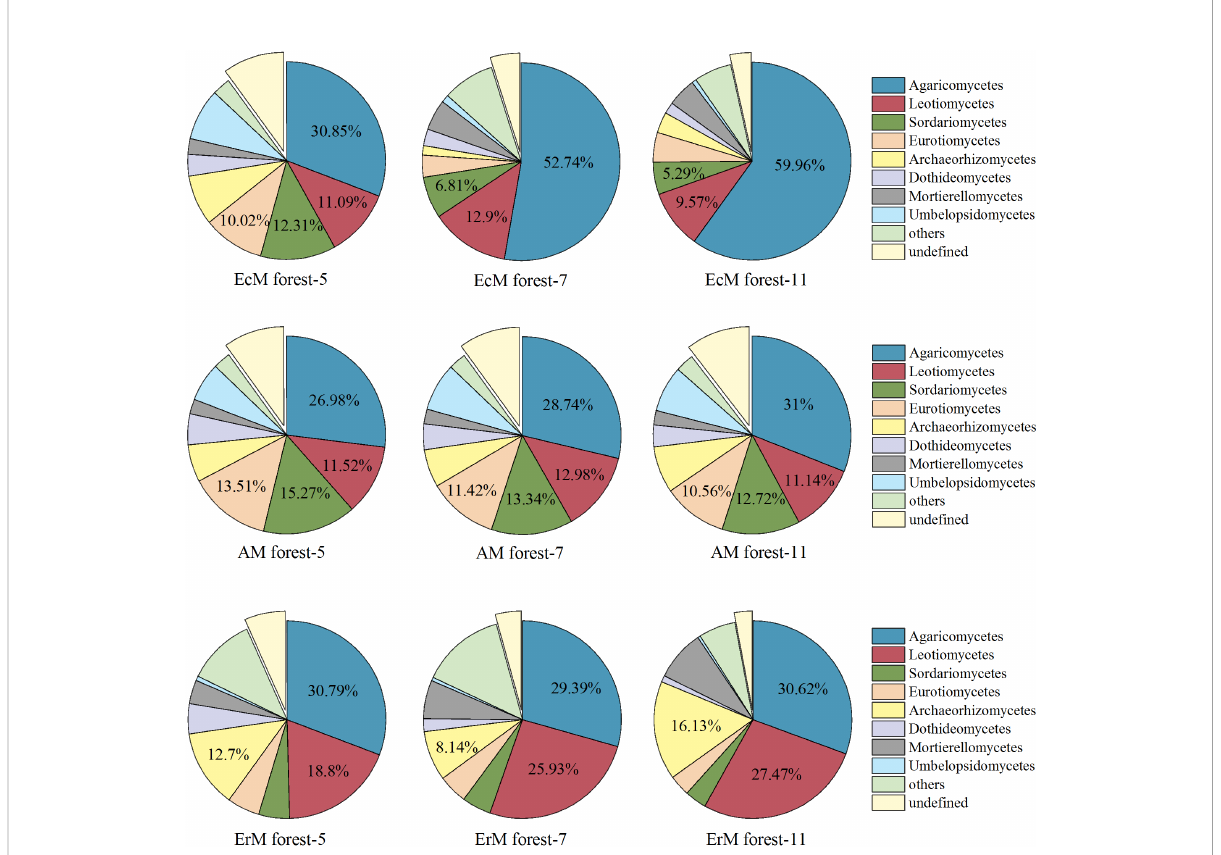
FIGURE 3 Relative abundances of soil fungal at the class level among three mycorrhizal forests in each different sampling month. ‘ Others ’ represent the sum of all classes with the relative abundance less than 1%. EcM forest, Abies fargesii var. faxoniana primary forest; AM forest, Cupressuschengiana primary forest; ErM forest, Rhododendron phaeochrysum primary forest; -5, -7 and -11 represented May, July and November